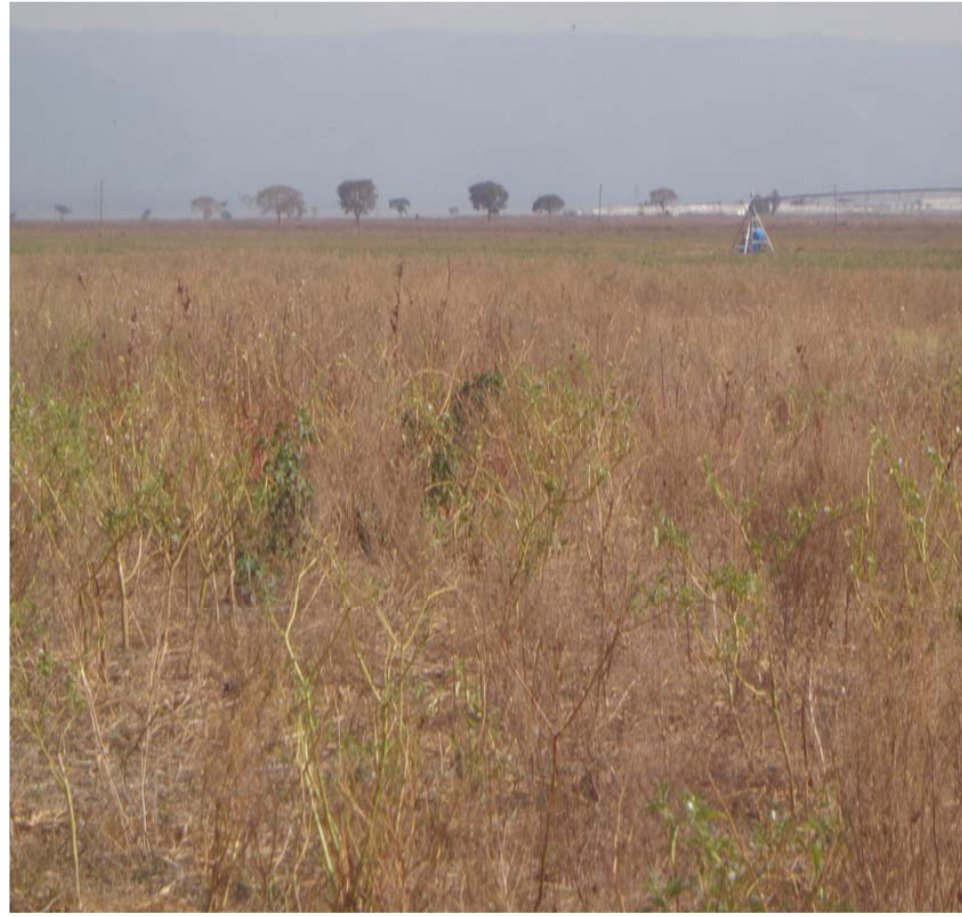
Figure 3. Elfora large ‐ scale crop production farm in the Shashamane district, which is responsible for planting, transplanting, growing, and harvesting plant material, including food crops and export/industrial crops (left side). (Source: authors).